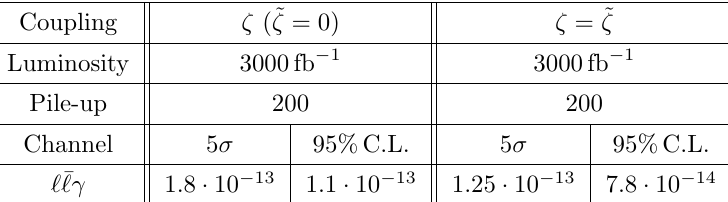
Table 5 . 5 (cid:27) discovery and 95% C.L. exclusion limits on (cid:16) , ~ (cid:16) . Sensitivities are given for 3000 fb (cid:0) 1 and (cid:22) = 200 average pile-up interactions, which corresponds to the High Luminosity LHC. Sensitivities for the jj(cid:13) channel are not quoted in this scenario, due to the high number of background events which compromises signi(cid:12)cantly the signal